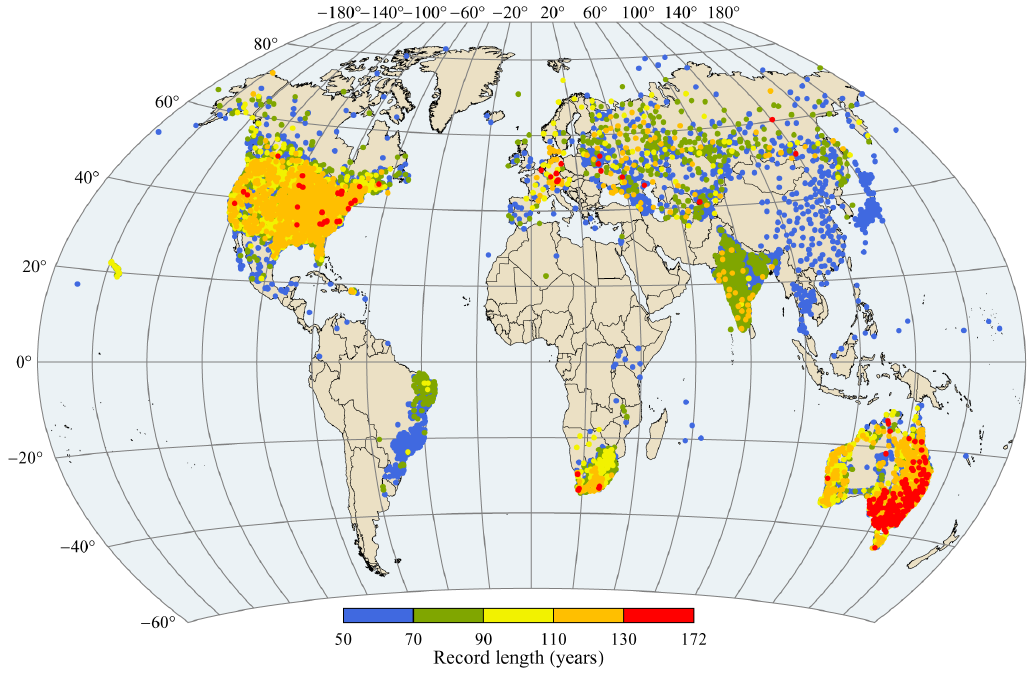
Fig. 2. Locations of the stations studied (a total of 15137 daily rainfall records with time series length greater than 50yr). Note that there are overlaps with points corresponding to high record lengths shadowing (being plotted in front of) points of lower record lengths.